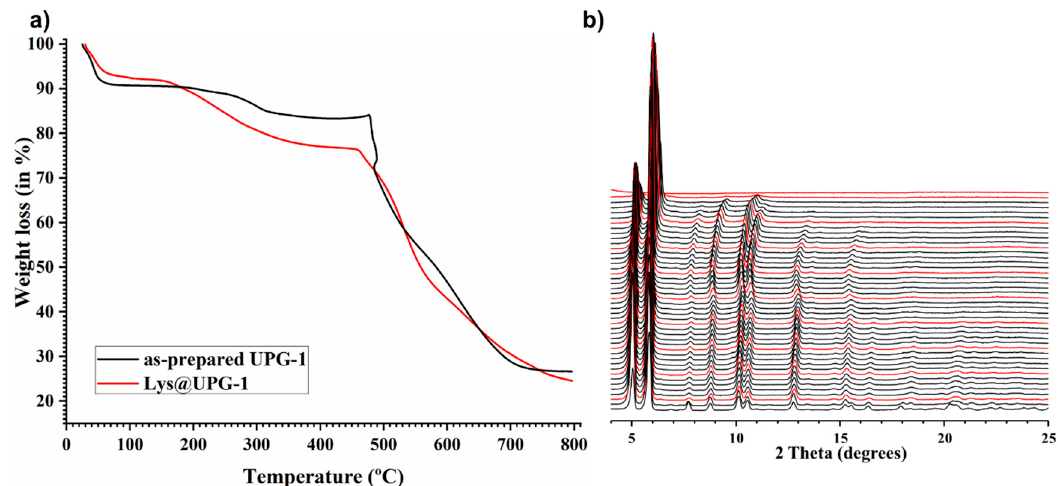
Figure 2. ( a ) Thermogravimetric analysis (TGA) of UPG-1 and Lys@UPG-1 and ( b ) VTPXRD patterns of UPG-1 from 30 to 500 °C. Each red line corresponds to an increment of 50 °C. No significant structural changes are observed up to ca. 440 °C, besides some shift of the peaks, at higher temperatures ( i.e ., from ca. 350 °C) and loss of crystallinity after ca. 400 °C. An amorphous residue appears at about 500 °C.